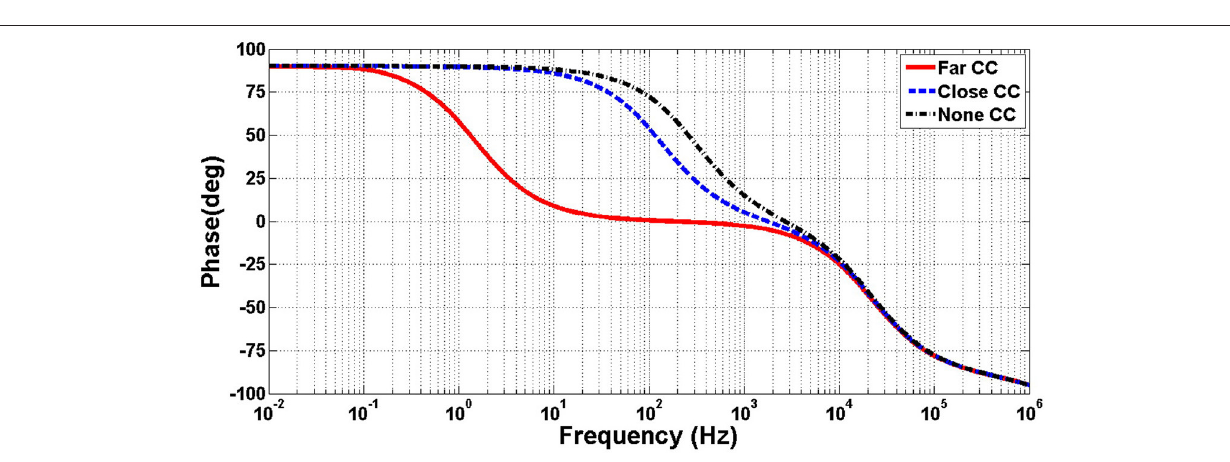
FIGURE 10 | Simulation of frequency response (phase) of the amplifier of Figure 8 with far, close and no CCPF